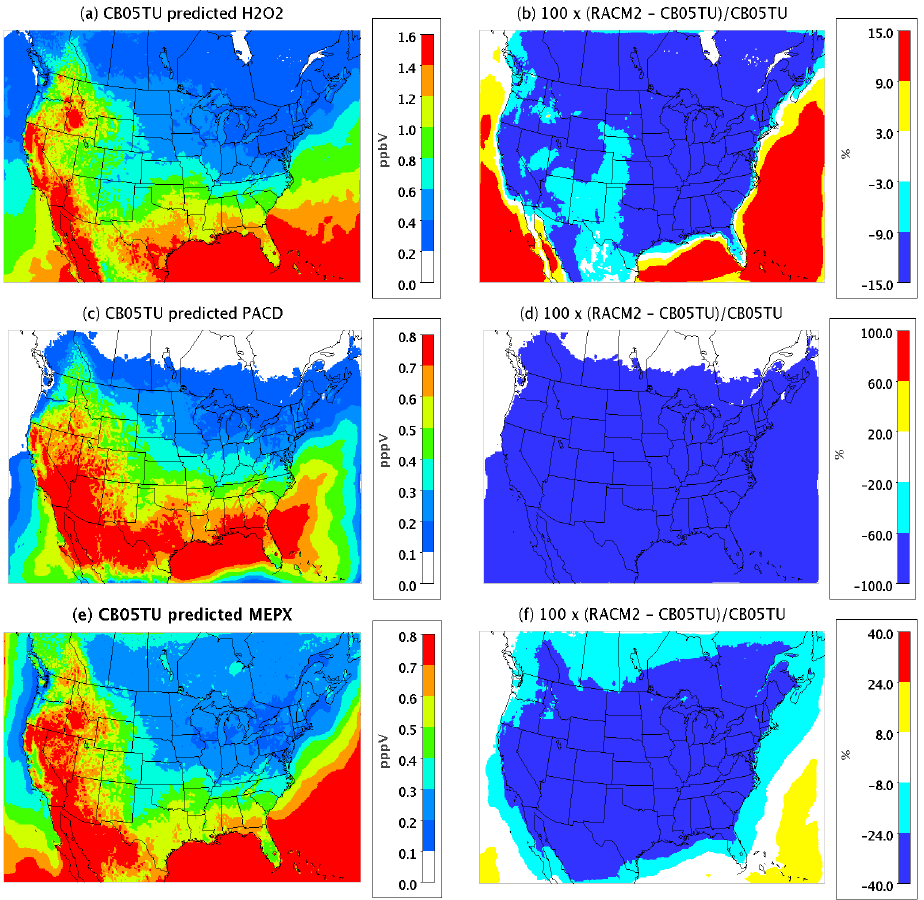
O obtained with CB05TU (b) percent differences in mean H 2 2 a